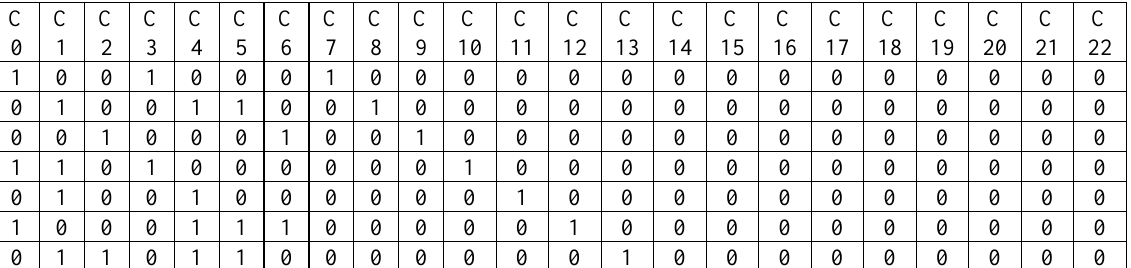
Table 1. Construction of generator